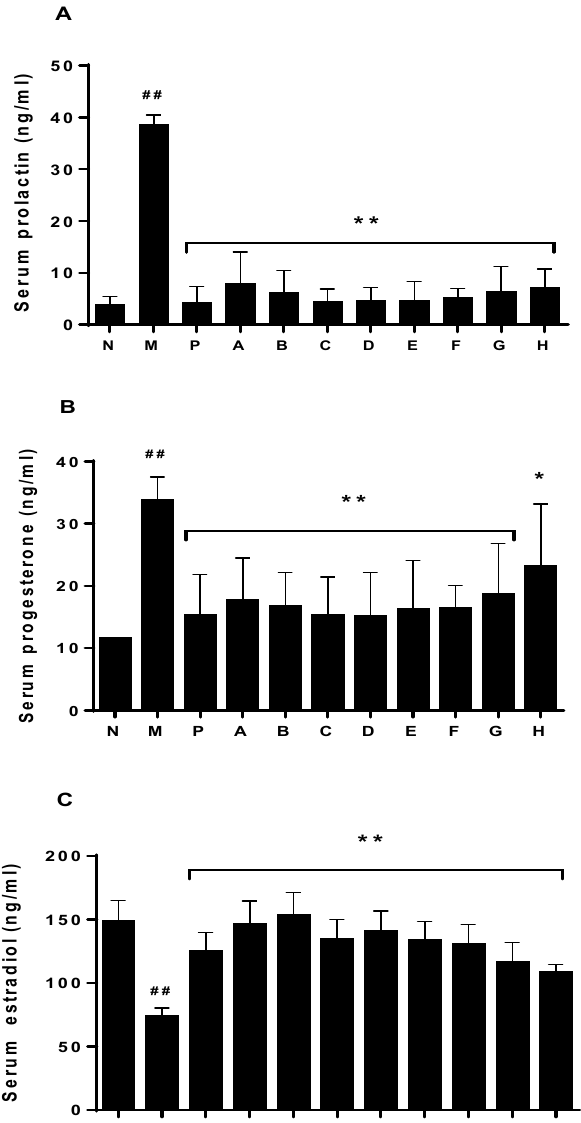
FIGURE 3 – The effects of decoction of different buds of malt on the contents of PRL, P and E2 in serum of HPRL rat model. Rat model of HPRL was produced by injection of 75 mg/kg MCP for 10 days, followed by treatment with or without 9.46 g/kg decoction of different buds of malt (A to H) or 0.4 mg/kg BMT (P) for 30 days. 0.9% salt solution-treated rats were served as model group (M). Normal group were non-modeling and treated (N). After the completion of experimental treatment, serum of rats in each group was collected serum PRL (A), P (B) and E2 (C) levels were determined by ELISA. Data are expressed as mean ± SEM (n = 9). ## P < 0.01 vs. normal group, * P < 0.05 and ** P < 0.01 vs. model